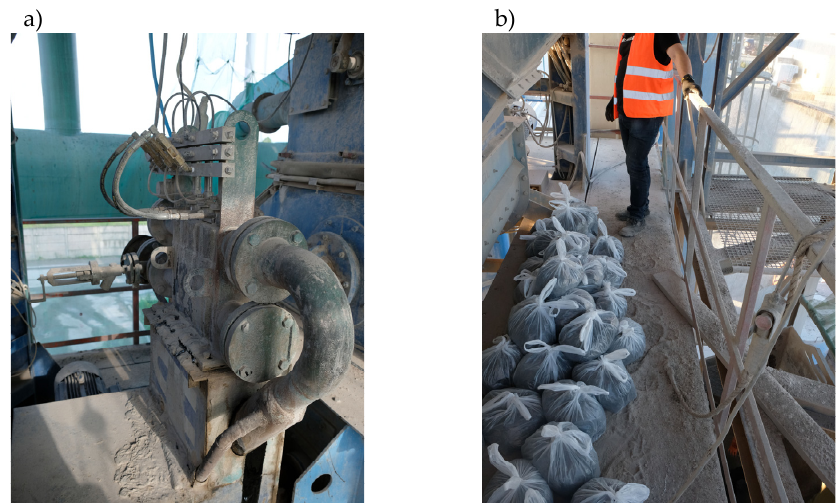
Figure 2. Plant production of asphalt mixtures: Green Pac asphalt foaming system ( a ), batches of basalt fibers prepared for mixing ( b ).